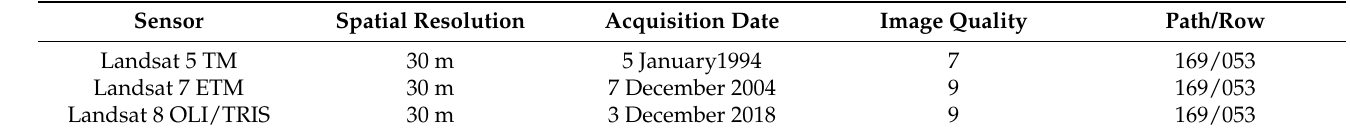
Table 3. Attributes of Landsat